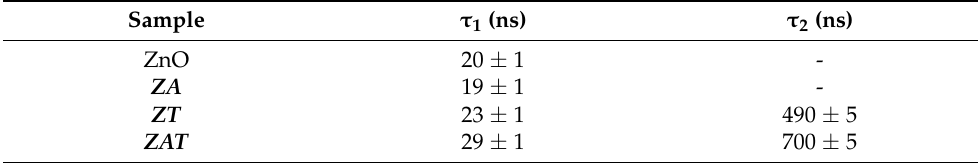
Table 1. Time parameter of the multi-decay process model with corresponding samples.